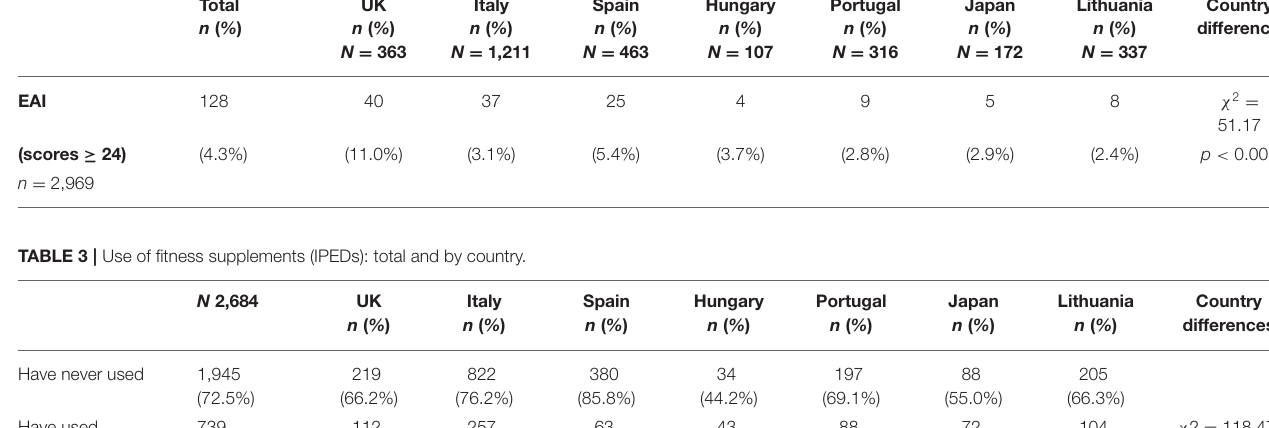
TABLE 2 | Problematic exercise (EAI ≥ 24): total and by country.